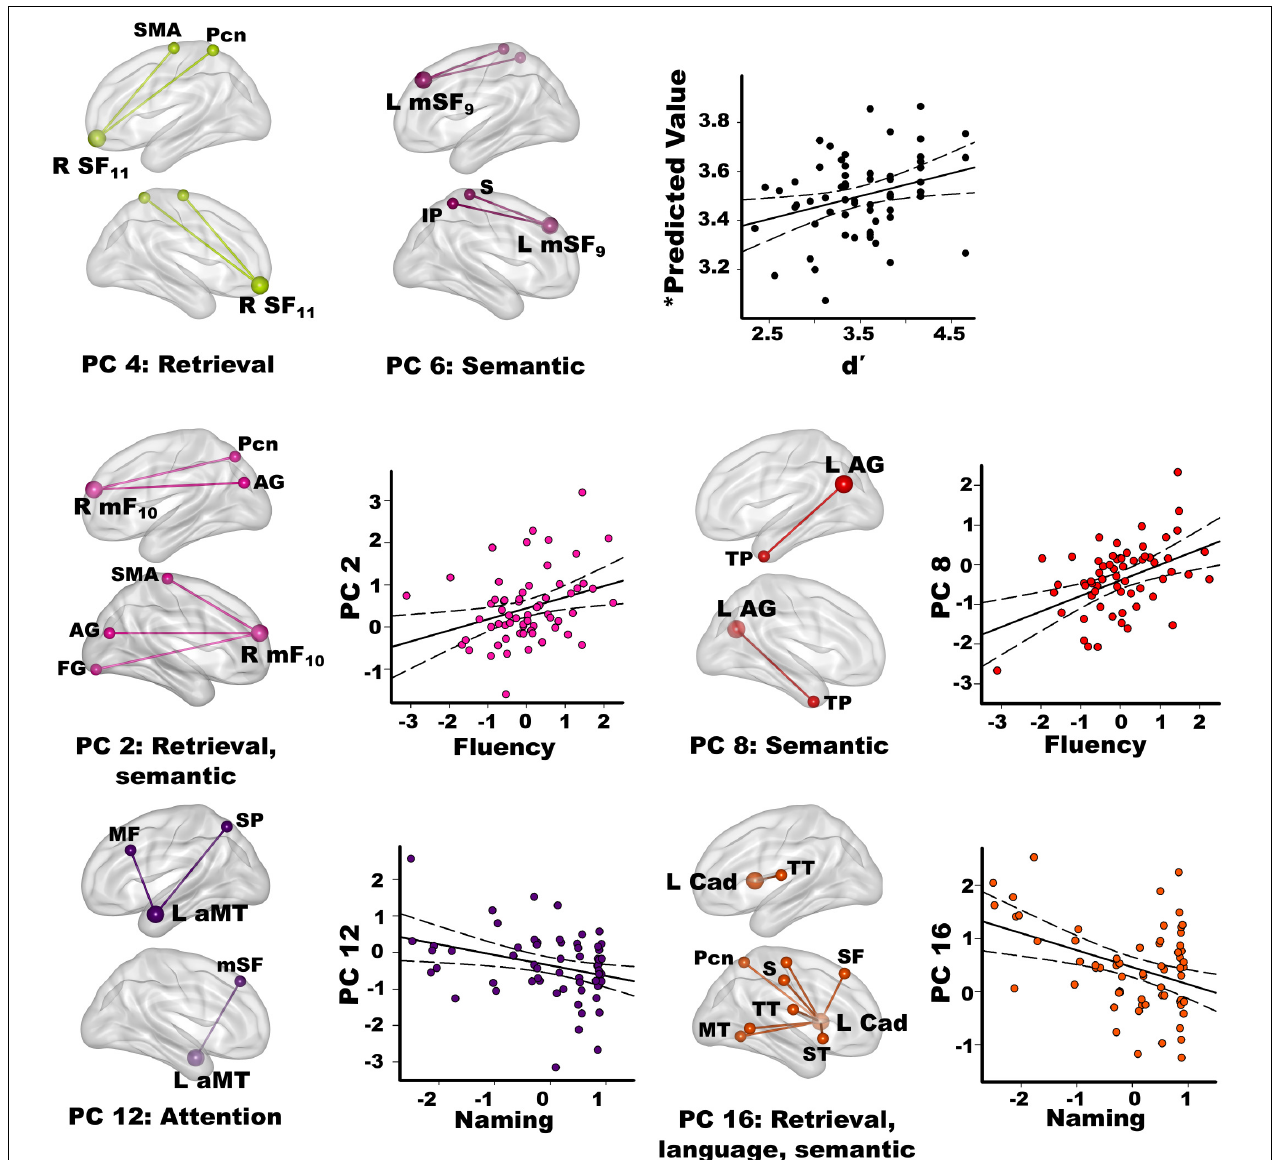
FIGURE 4 | Relationships between semantic cognition and principal component scores in the PD group. Fame-discrimination ( d ’), category fluency (DKFES Category Fluency), and confrontation naming (Boston Naming Test) performances significantly correlated with specific principal component (PC) scores. For each PC, seed(s) (large balls) and their connection(s) (small balls) are color coded. Significant correlations between standardized PC scores ( y axis) and measures of semantic cognition are shown on scatterplots for the PD group. Plots display the best-fitting linear regression line (solid line) and 95% conference intervals (dotted lines). Age adjusted residuals are plotted for Category Fluency and Confrontation Naming tests. For d ’ (top row) , predicted values from the regression equation are plotted for frontal PC 4 and PC 6 [ (cid:54) intercept + (beta PC 4 * PC 4 score) + (beta PC 6 * PC 6 score) = (cid:54) 3.4 + (0.19 * PC 4 score) + (0.16 * PC 6 score)]. Brodmann areas for frontal seeds are designated by subscripts. L, left hemisphere; R, right hemisphere. AG, angular gyrus; aMT, anterior middle temporal; Cad, caudate; FG, fusiform gyrus; IP, inferior parietal; IT, inferior temporal; mF, medial frontal; mSF, medial superior frontal; MF, middle frontal; MT, middle temporal; Pcn, precuneus; PC, posterior cingulate; S, sensory; SF, superior frontal; SMA, supplementary motor; SP, superior parietal; ST, superior temporal; TP, temporal pole; TT, transverse